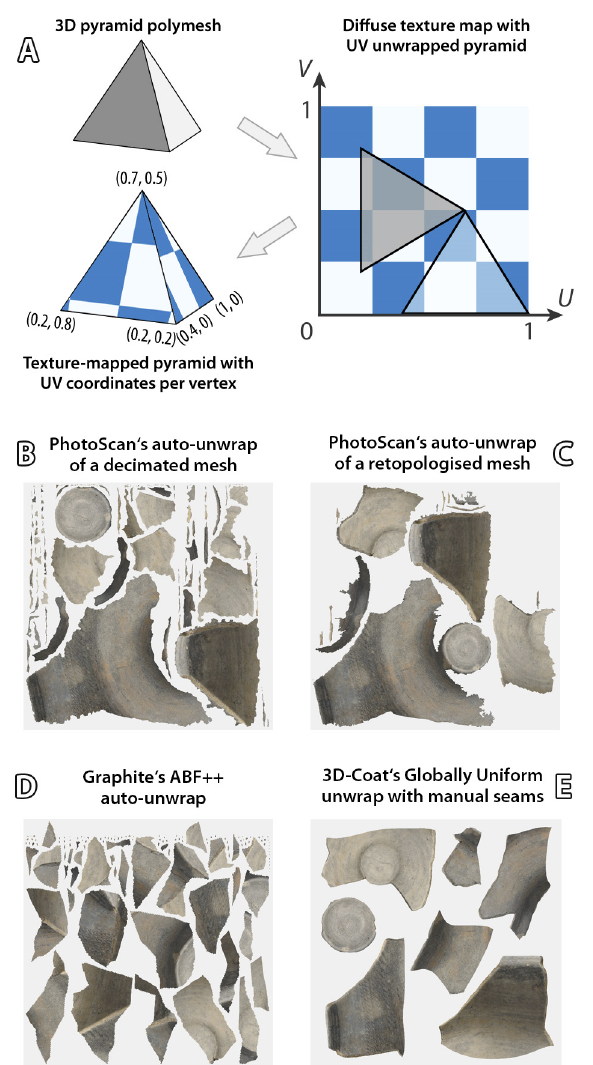
Figure 4. (A) illustrates the process of UV mapping a pyramid. (B) and (C) are the texture maps that result from PhotoScan’s ‘Generic’ parameterisation of the mesh in Figure 2A and 2B, respectively. (D) displays the texture atlas obtained in Graphite using the ABF++ unfolding algorithm (Sheffer et al., 2005), while (E) shows the result of 3D-Coat’s proprietary Globally Uniform unwrapping after manually placing a few seams. Both (D) and (E) were executed on the retopologised